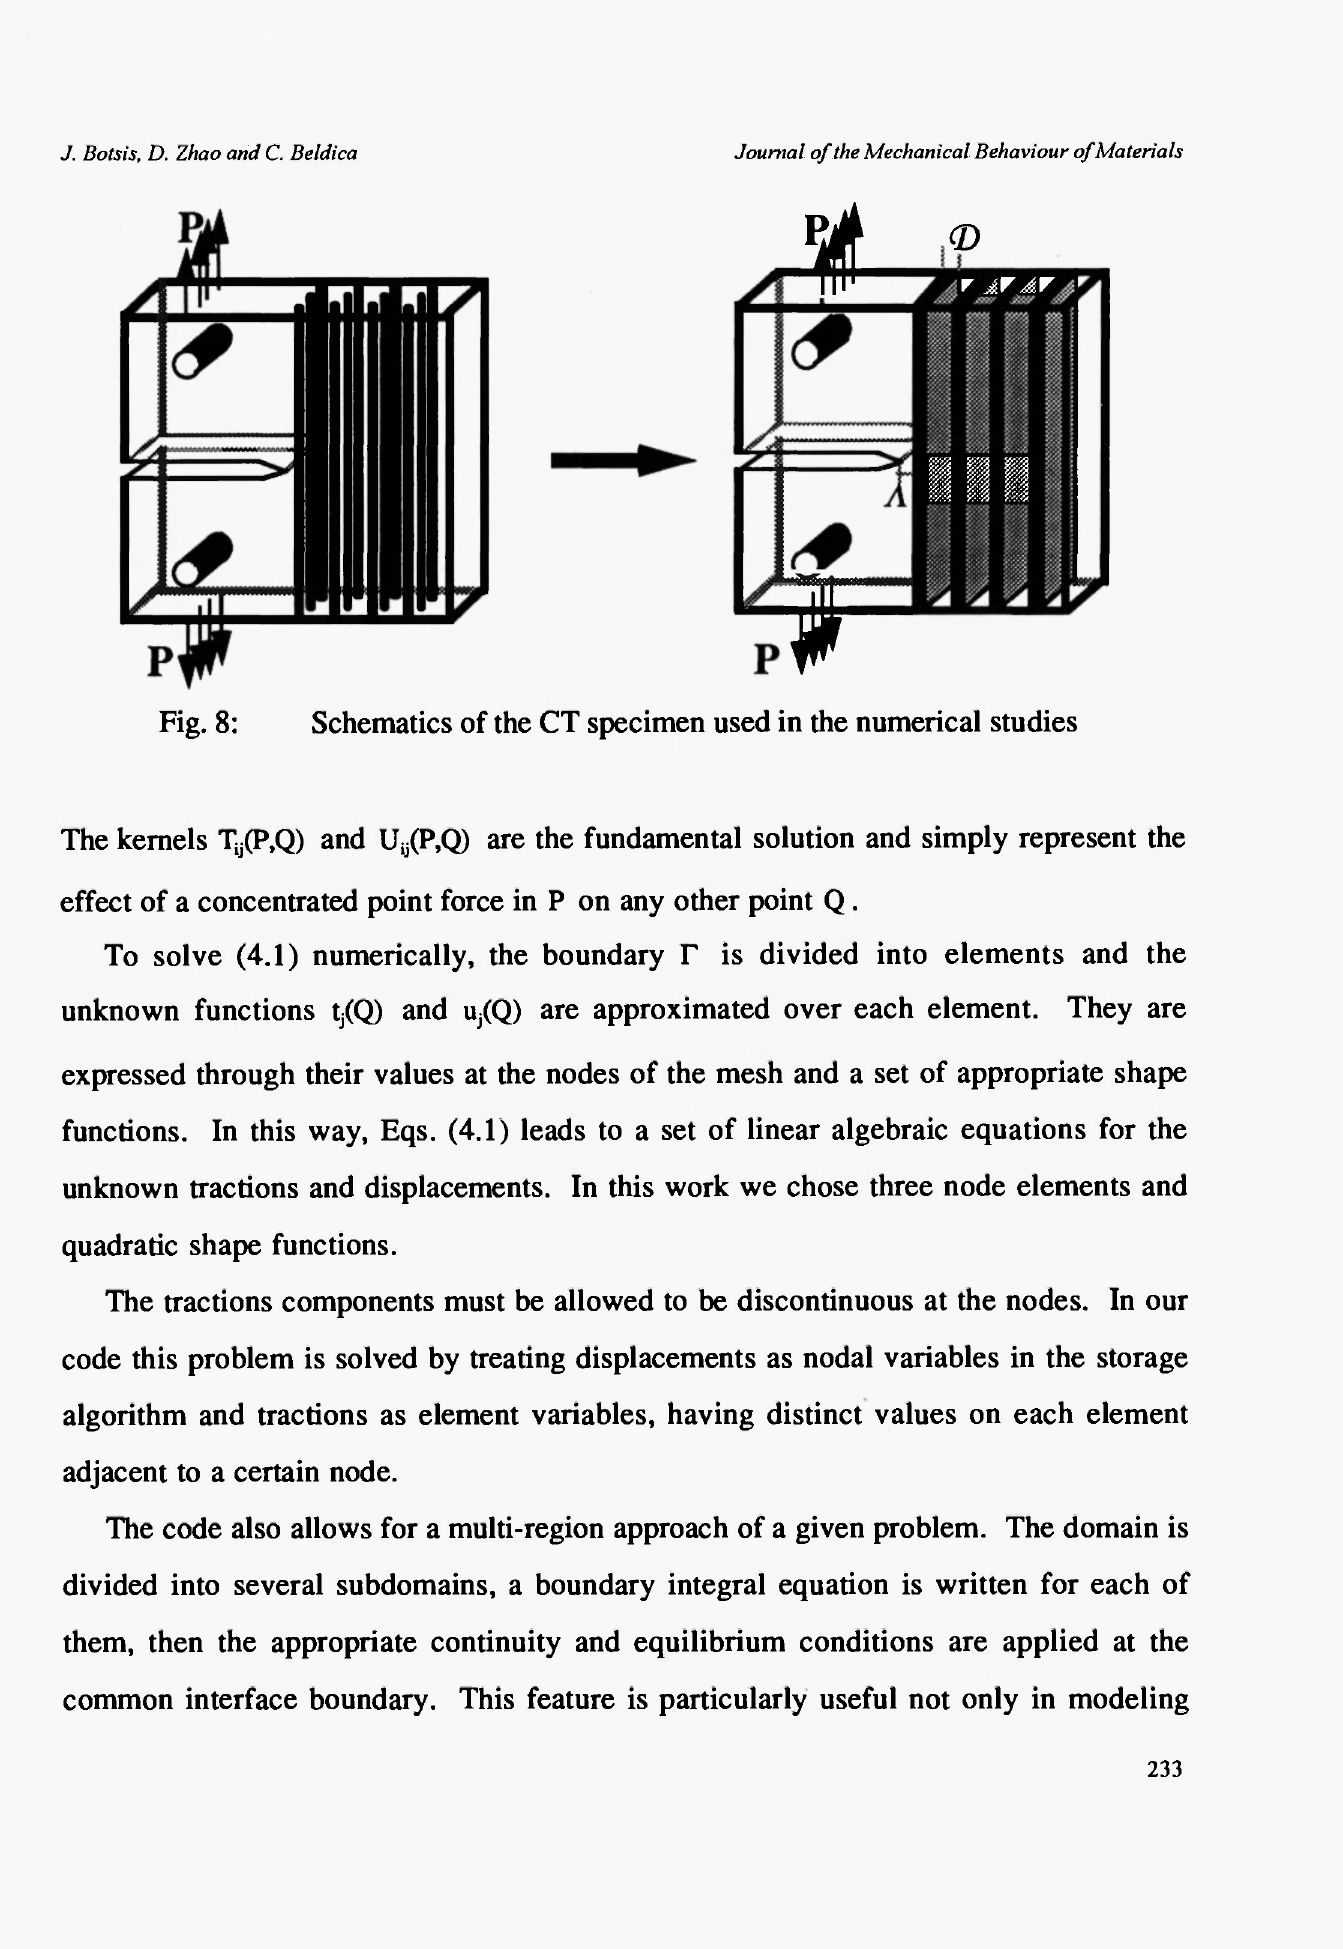
The kernels T^P.Q) and U (P,Q) are the fundamental solution and simply represent the y effect of a concentrated point force in Ρ on any other point